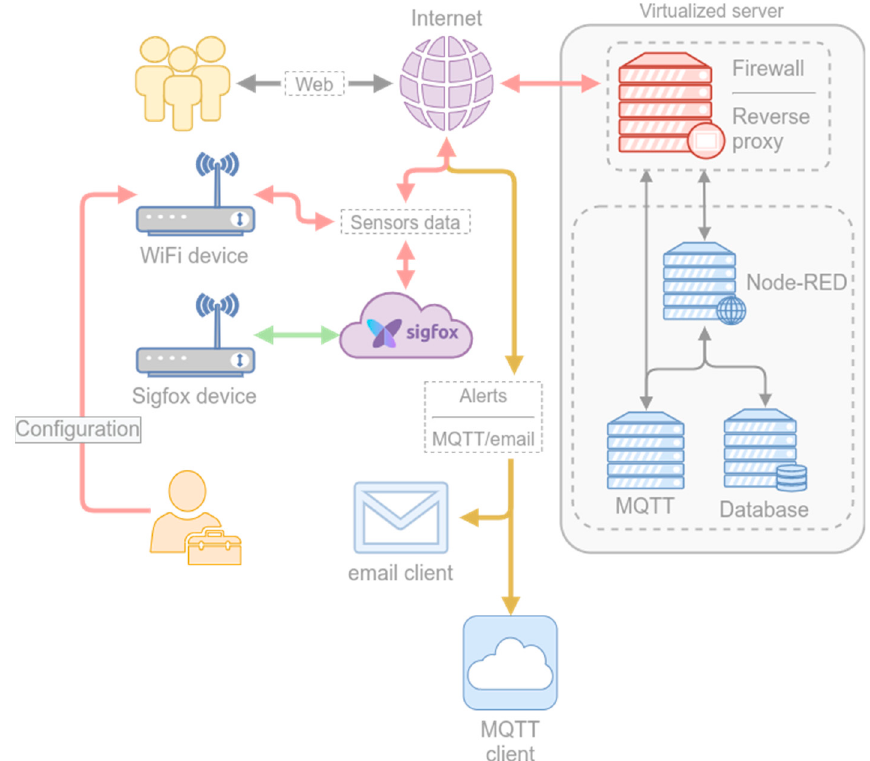
Figure 3. Architecture of the radon detection and alert system.